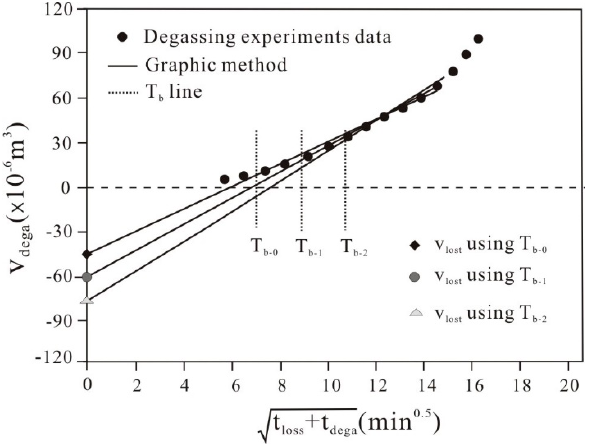
Figure 7. The calculation of lost gas volume in three types of temperature balance time.